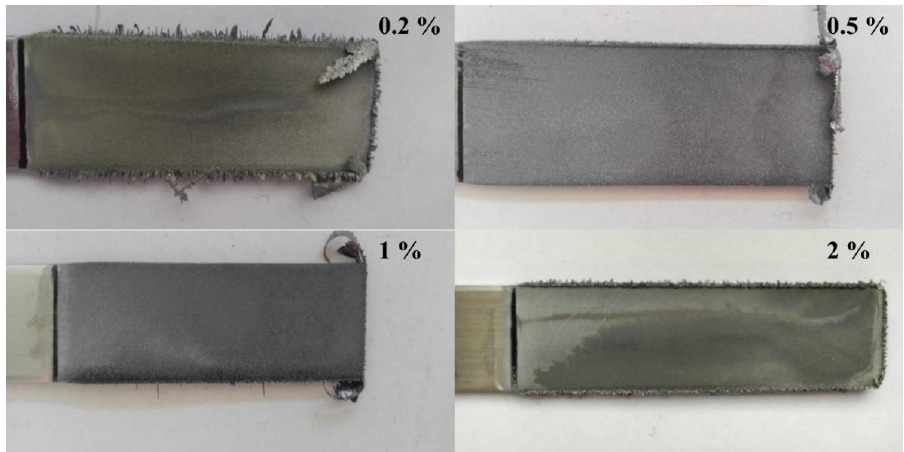
Figure 6. Photos of the electrodeposited lead at different concentrations of ethylene glycol as an inhibitor.